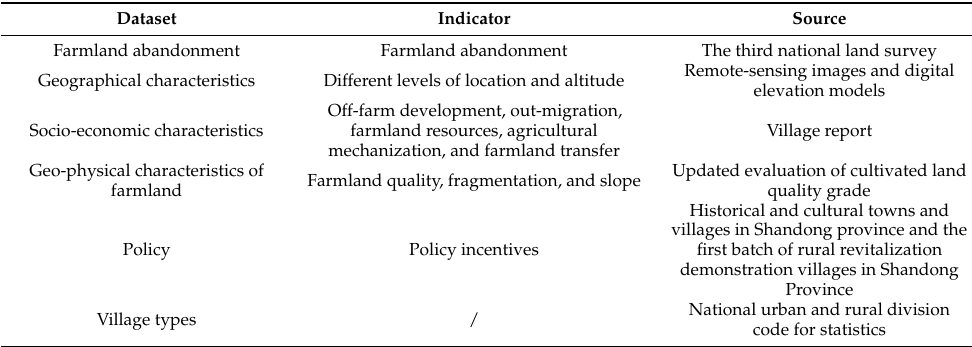
Table 1. Datasets of the study.